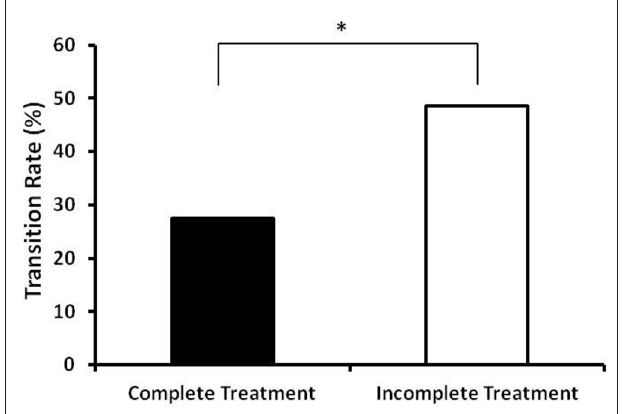
FIGURE 2 | Transition rates from situational insomnia to chronic insomia in the complete treatment group and incomplete treatment group. The complete treatment group had a significantly lower transition rate compare to the incomplete treatment group (27.5%, 14/51 vs. 48.5%, 32/66). *Indicates significant differences between the two groups ( p < 0.05).